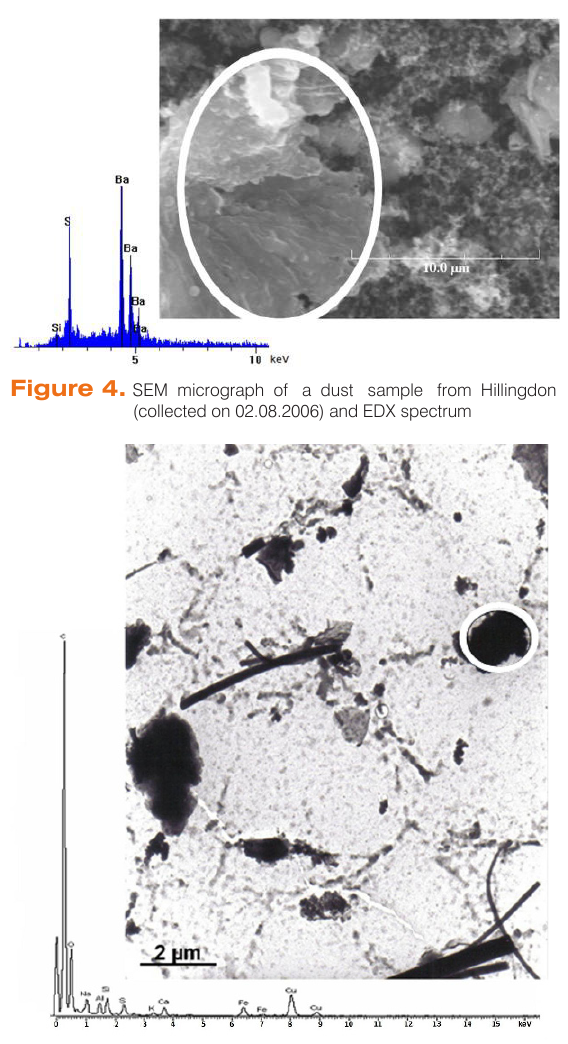
Figure 5. TEM micrograph of a dust sample from Hillingdon (collected on 08.06.2006): the fibers seen in the micrograph are from the glass fiber filter and EDX spectrum